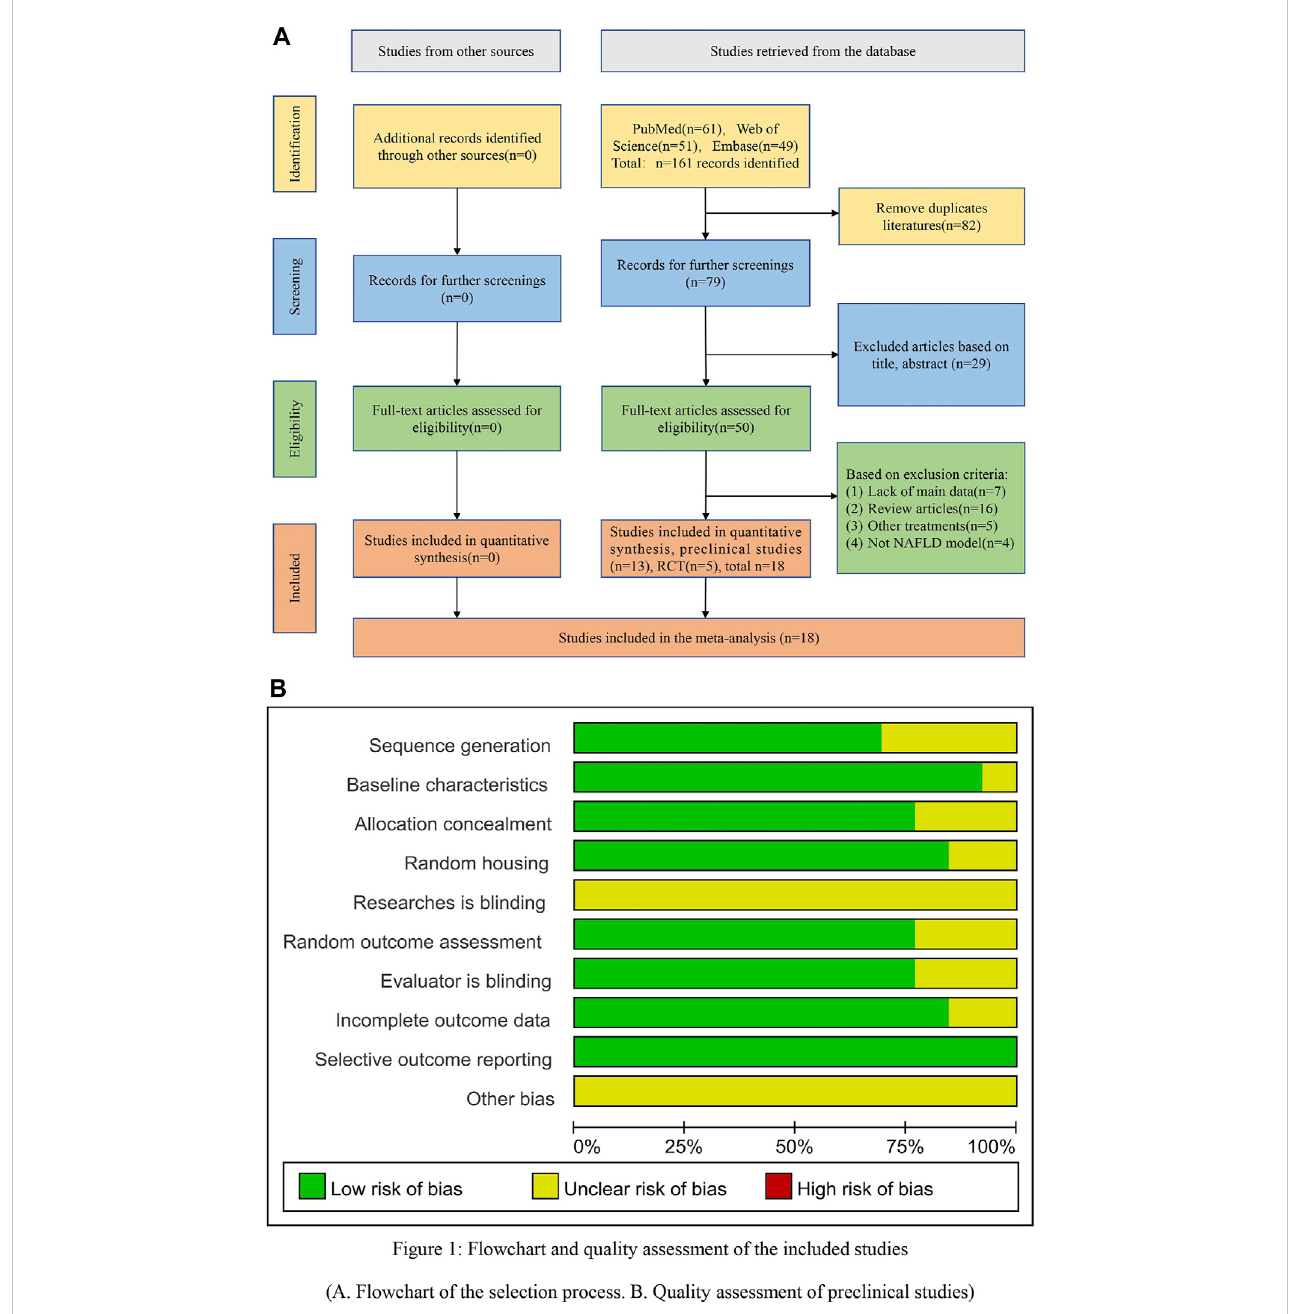
FIGURE 1 Flowchart and quality assessment of the included studies. (A) Flowchart of the selection process. (B) Quality assessment of the preclinical studies.